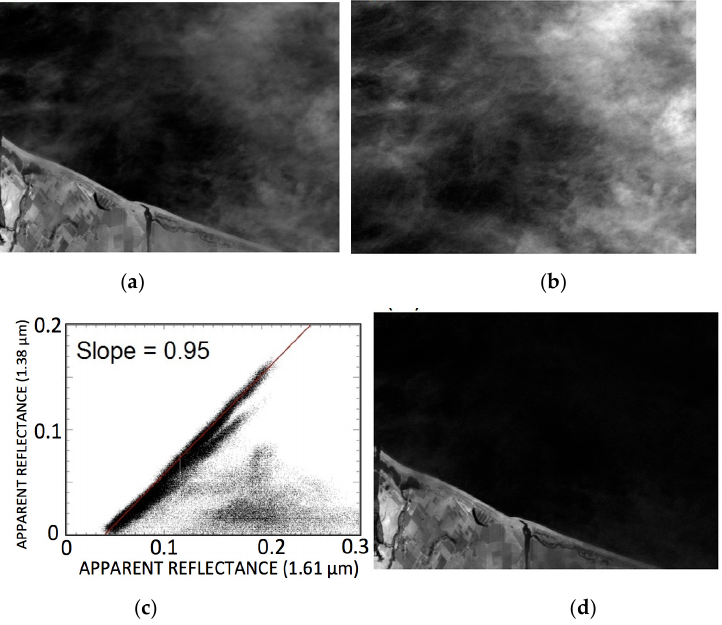
Figure 4. ( a ) An AVIRIS 1.61- µ m band image acquired over land and water surfaces; ( b ) The 1.38- µ m cirrus band image; ( c ) Scatter plot of 1.38- µ m band apparent reflectance image versus the 1.61- µ m band image; ( d ) Cirrus scattering effect removed 1.61- µ m band